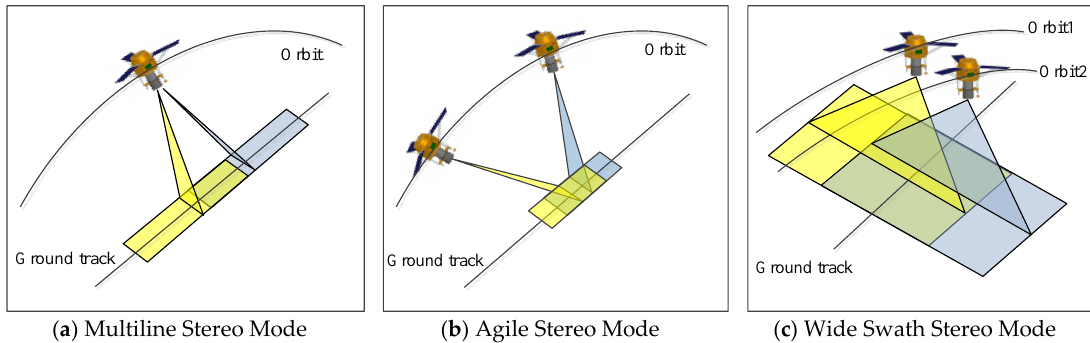
Figure 1. Three different stereo mapping mode. ( a ) Multiline array cameras attain multiple images at different angles, baselines, and overlapping areas, ( b ) one camera observes the same area from different angles at the same orbit by the attitude maneuver, ( c ) one camera observes the same area from different orbits without requiring attitude agility.